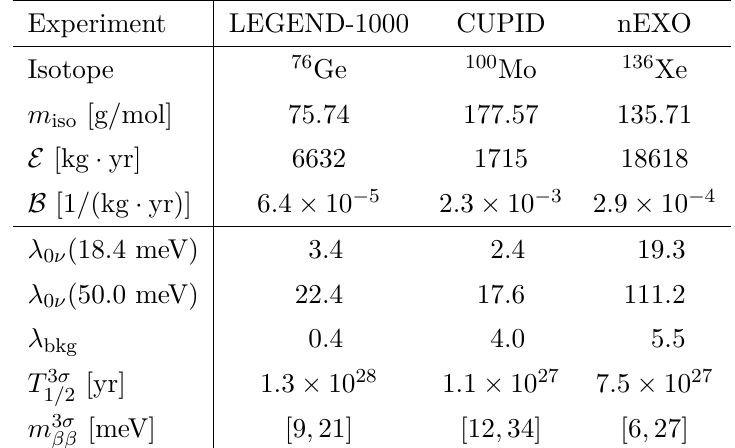
Table 2 . Parameters modelling the likelihood for LEGEND-1000, CUPID and nEXO as count- based experiments: molar mass m iso , effective exposure E and background rate B . For these setups, also listed are: the expected number of 0 νββ signal events λ 0 ν for m ββ = 18 . 4 meV and 50 meV, the expected number of background events λ bkg , the resulting 3 σ discovery sensitivity T 3 σ corresponding sensitivity m 3 σ on the effective mass, expressed as a range due to NME uncertainties. ββ The values are taken from